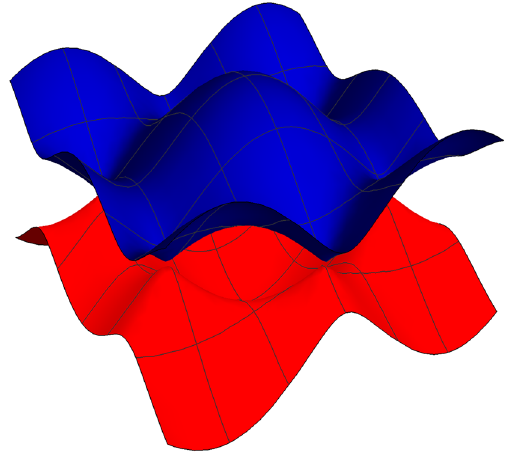
Fig. 2 Energy-momentum dispersion relation for the honeycomb array. There are six high-symmetric points in the Brillouin zone where valenceandconductingbands touch.Onlytwoofthem,theDiracpoints K and K (cid:3) , are